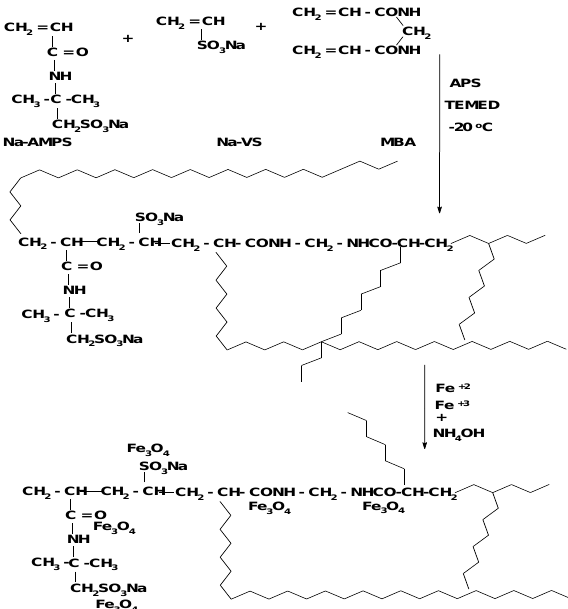
Figure 1. Preparation scheme of magnetite Na-VS/Na-AMPS cryogel composites.